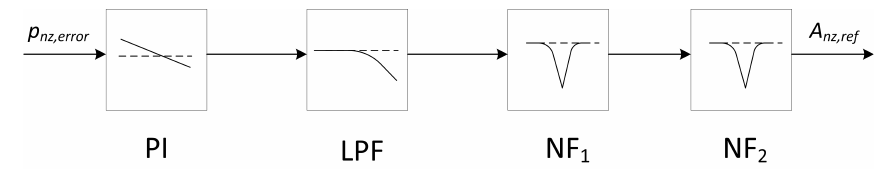
Figure 10. Schematic overview of the structure of the controller. The control blocks from left to right: proportional–integral (PI), low-pass filter (LPF), notch filter 1 (NF1), and notch filter 2 (NF2).